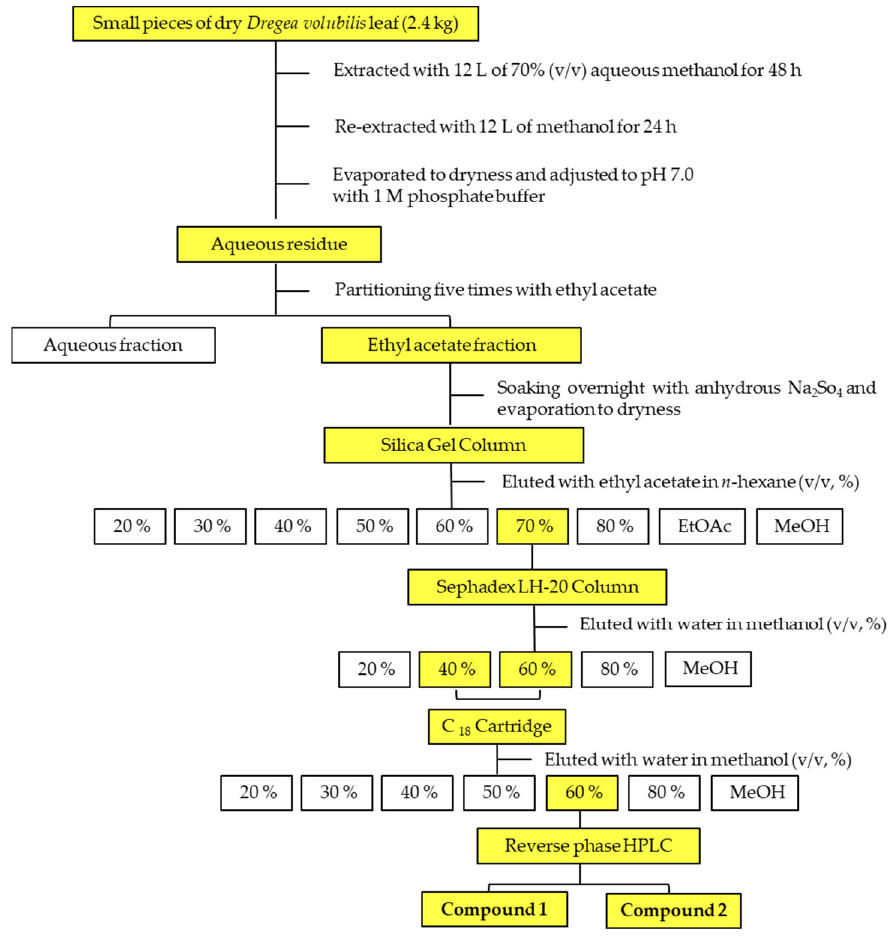
Figure 2 . Procedure for extracting and isolating two compounds from D. volubilis . Figure 2. Procedure for extracting and isolating two compounds from D. volubilis